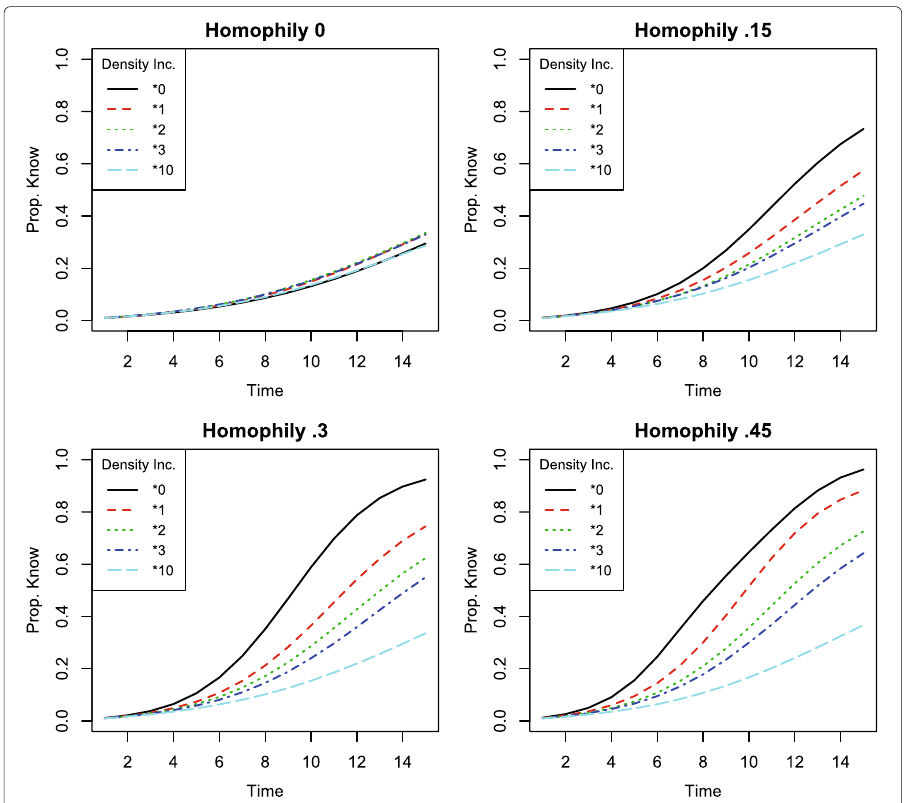
Fig. 3 Proportion of network informed by each timestep in simulated information spread on a network with τ = { τ 1 , τ 2 } , and q τ 1 = q τ 2 = 1 . Simulation parameters set to x = 2, p strong = 1, and p weak = .25. When 2 homophily is positive, increasing density changes neighborhood compositions and strictly impedes information diffusion; at this lower value of p weak , the impediment is even